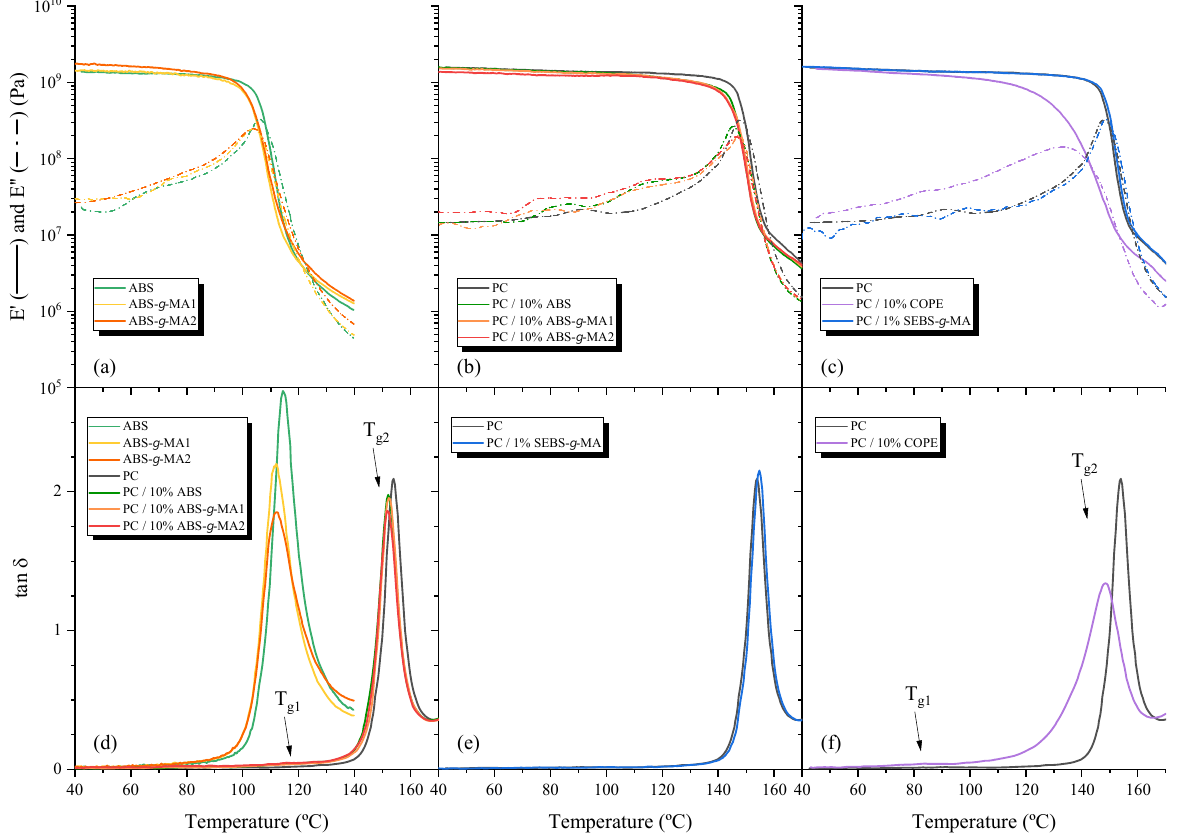
Figure 6. Dynamic mechanical analysis of ( a , d ) non and modified ABS, PC blends with ABS and ABS- g -MA ( b , d ), SEBS- g -MA and COPE ( c , e ), and PC/10% COPE deconvolution curves ( f ).